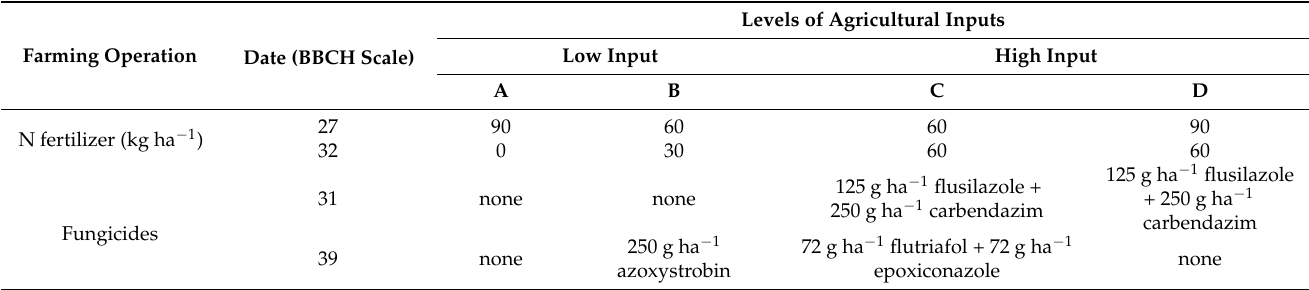
Table 1. Levels of agricultural inputs in the production of a semi-dwarf genotype of winter triticale (2008–2011).